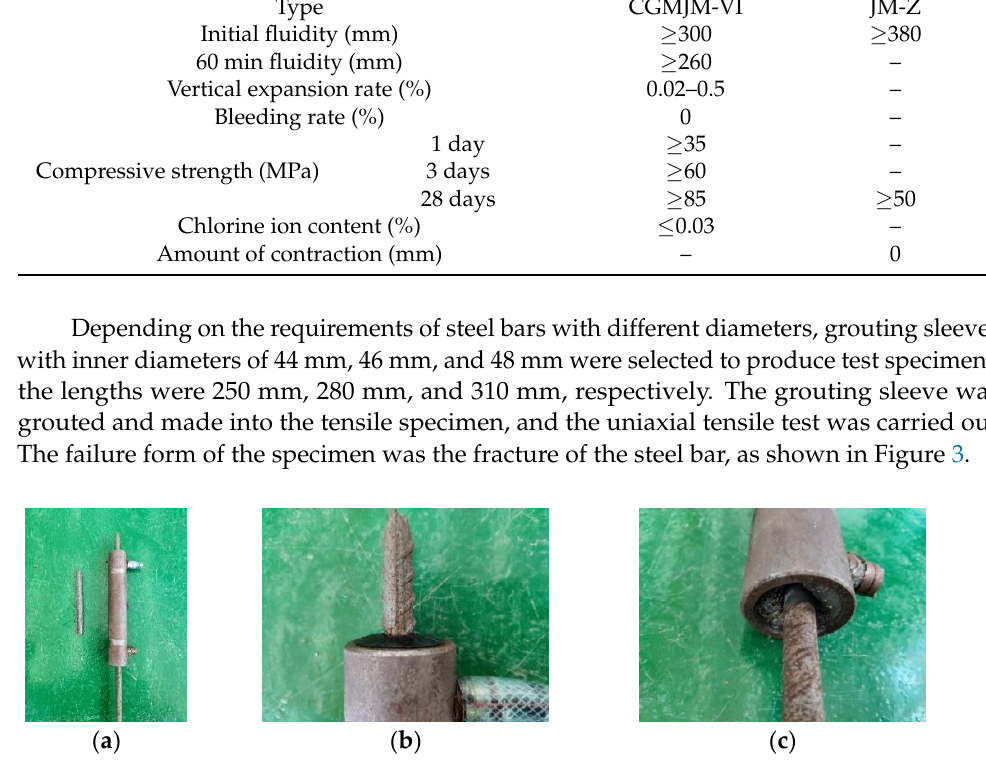
Figure 3. The failure mode of grouting sleeves. ( a ) Steel tensile. ( b ) The concrete expands and deforms. ( c ) Failure of concrete.